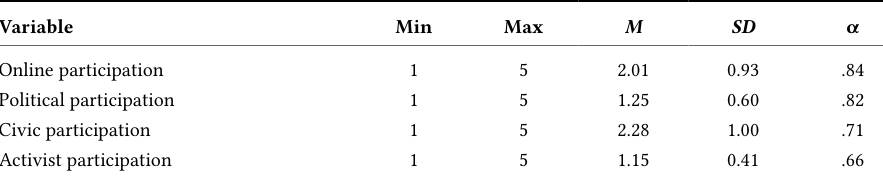
Sample Properties of Study